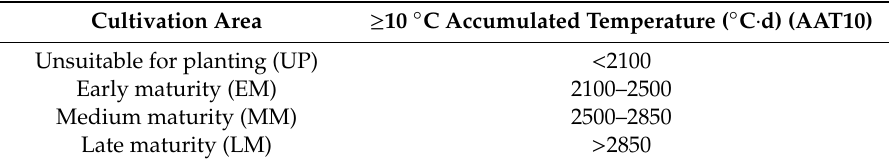
Table 1. Indicators for maize